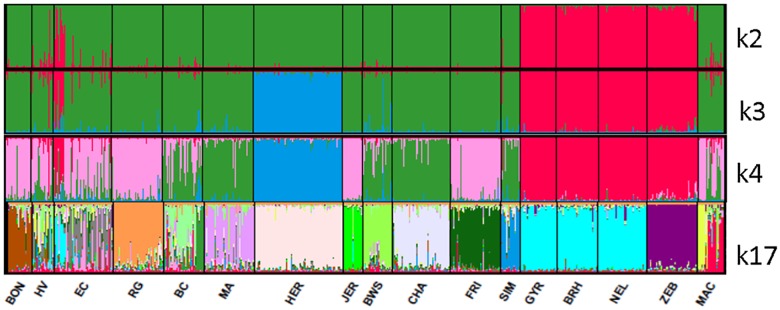
Graphic representation of the genetic structure analysis of the 17 cattle breeds.In each K graphic, the color represents the genetics partition found by the software.